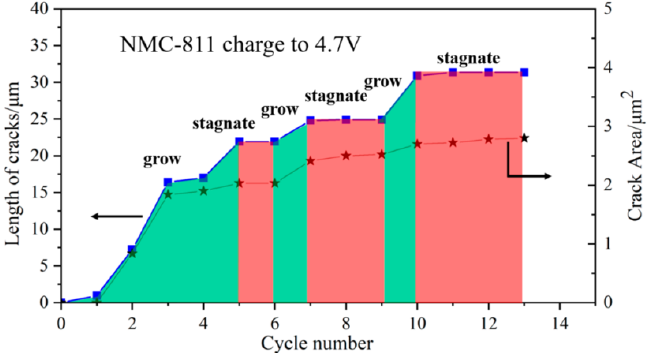
Figure 35. Measures of crack length and area as a function of number of cycles with in-situ SEM. The material is NMC811 cycled with a lithium counter electrode at 0.5C and 2.7 V–4.7 V. Reprinted with permission by Elesevier from [157], Copyright